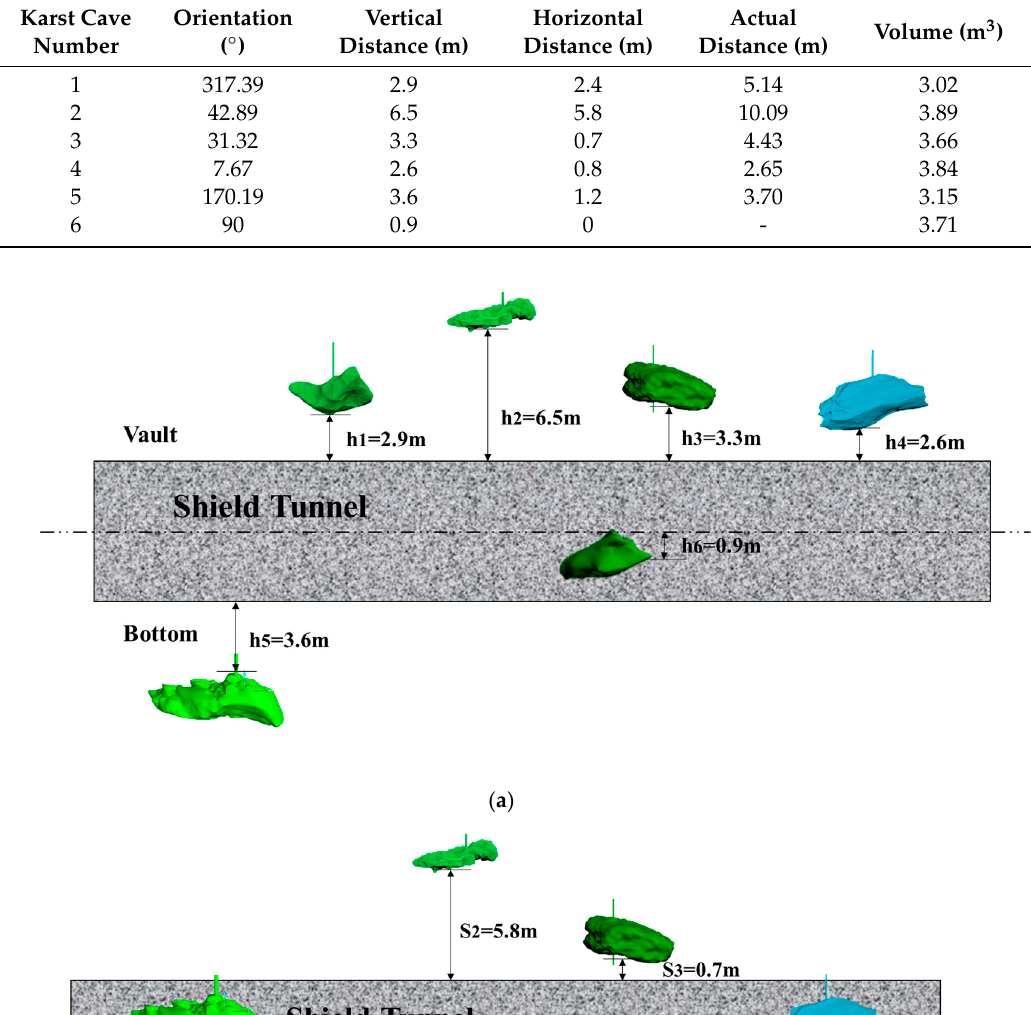
Table 4. Parameters of irregular caverns.